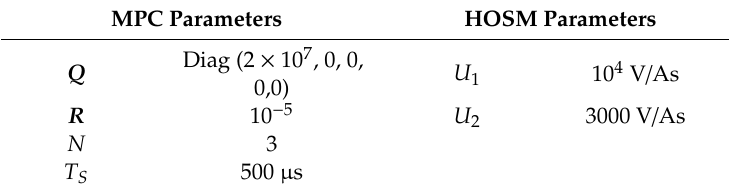
Table 2. Model Predictive Control (MPC) and Higher Order Sliding Mode (HOSM) controller parameters.